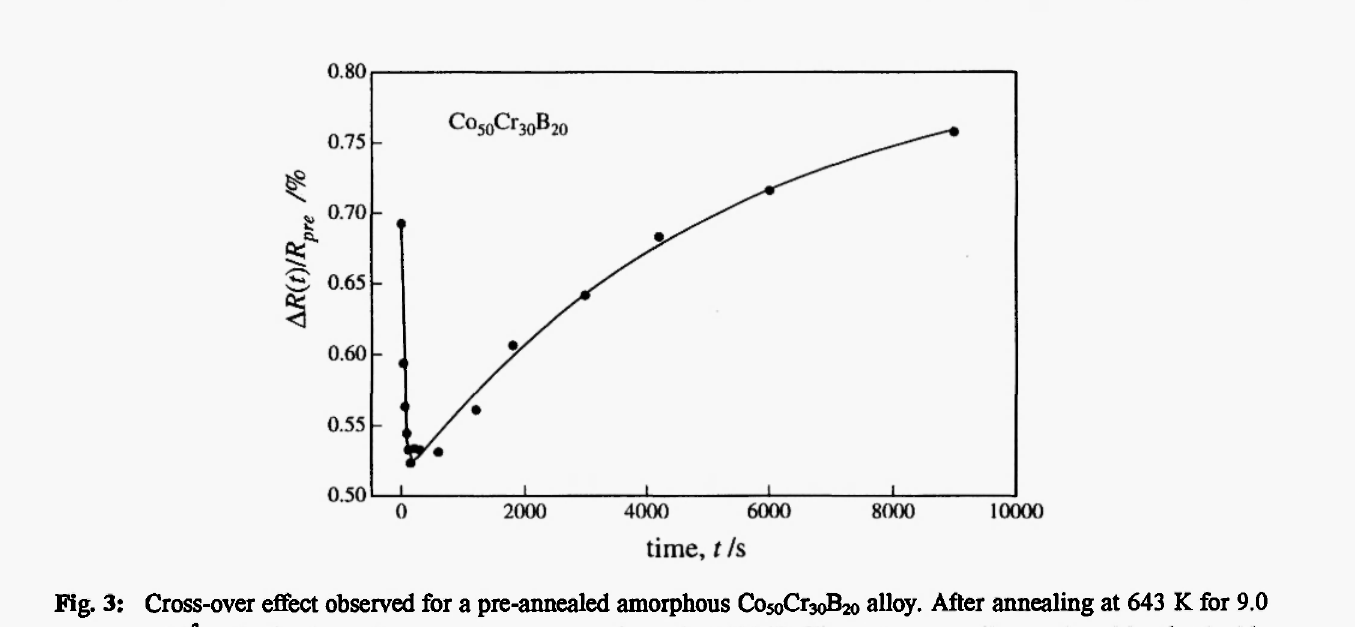
Fig. 3: Cross-over effect observed for a pre-annealed amorphous COSOÖWBM alloy. After annealing at 643 Κ for 9.0 χ 10 3 s, the isothermal measurement was performed at 683 K. The data was well reproduced by the double exponential function with fast and slow relaxation times.